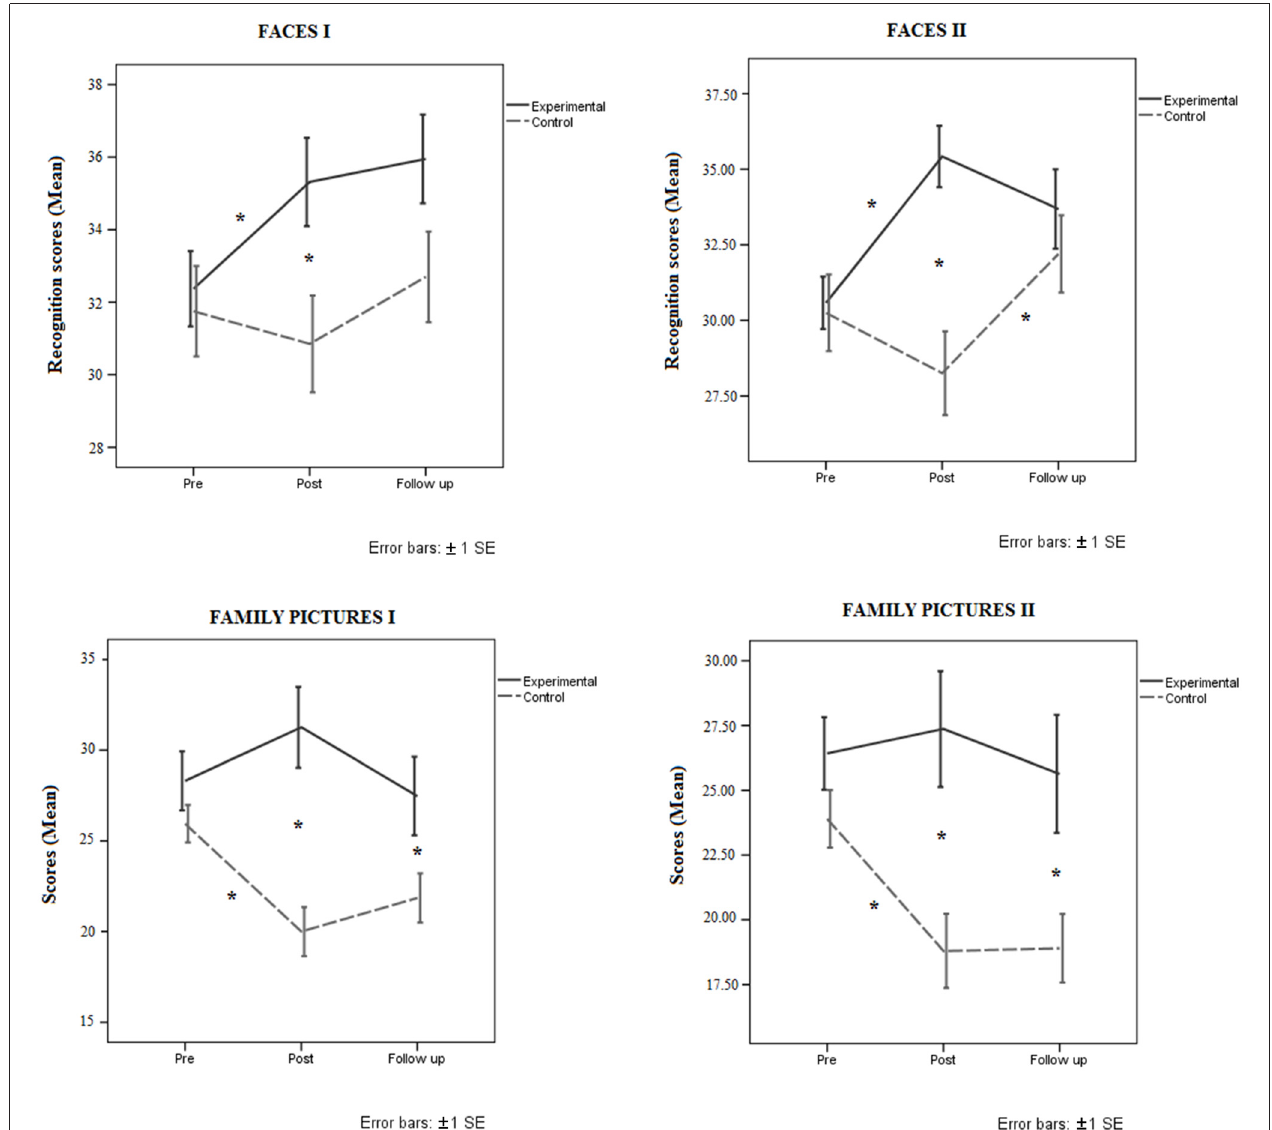
FIGURE 3 | Mean performance of trained and control groups at pre-test, post-test and follow-up in the episodic memory tasks. Top: Faces I (left) and Faces II (right). Bottom: Family Pictures I (left) and Family Pictures II (right). Error bars represent ± SE. ∗ p < 0.05.